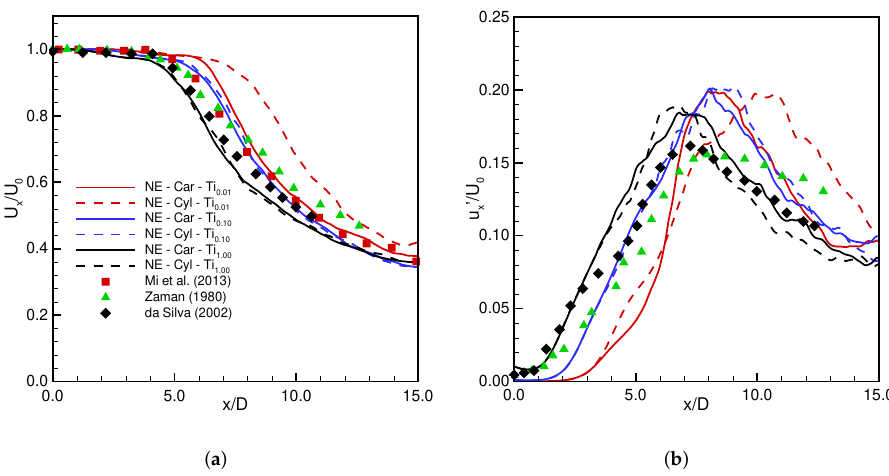
Figure 6. Profiles of the time-averaged axial velocity ( a ) and its fluctuations ( b ) along the jet axis. The comparison of the results obtained in the Cartesian and cylindrical coordinate systems